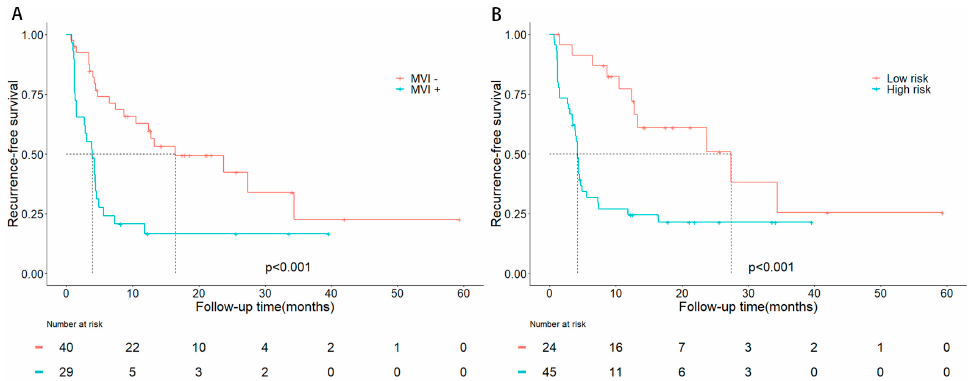
Figure 3. Kaplan ‒ Meier curves of recurrence-free survival stratified by histologic MVI status ( A ) and predicted MVI status ( B ).